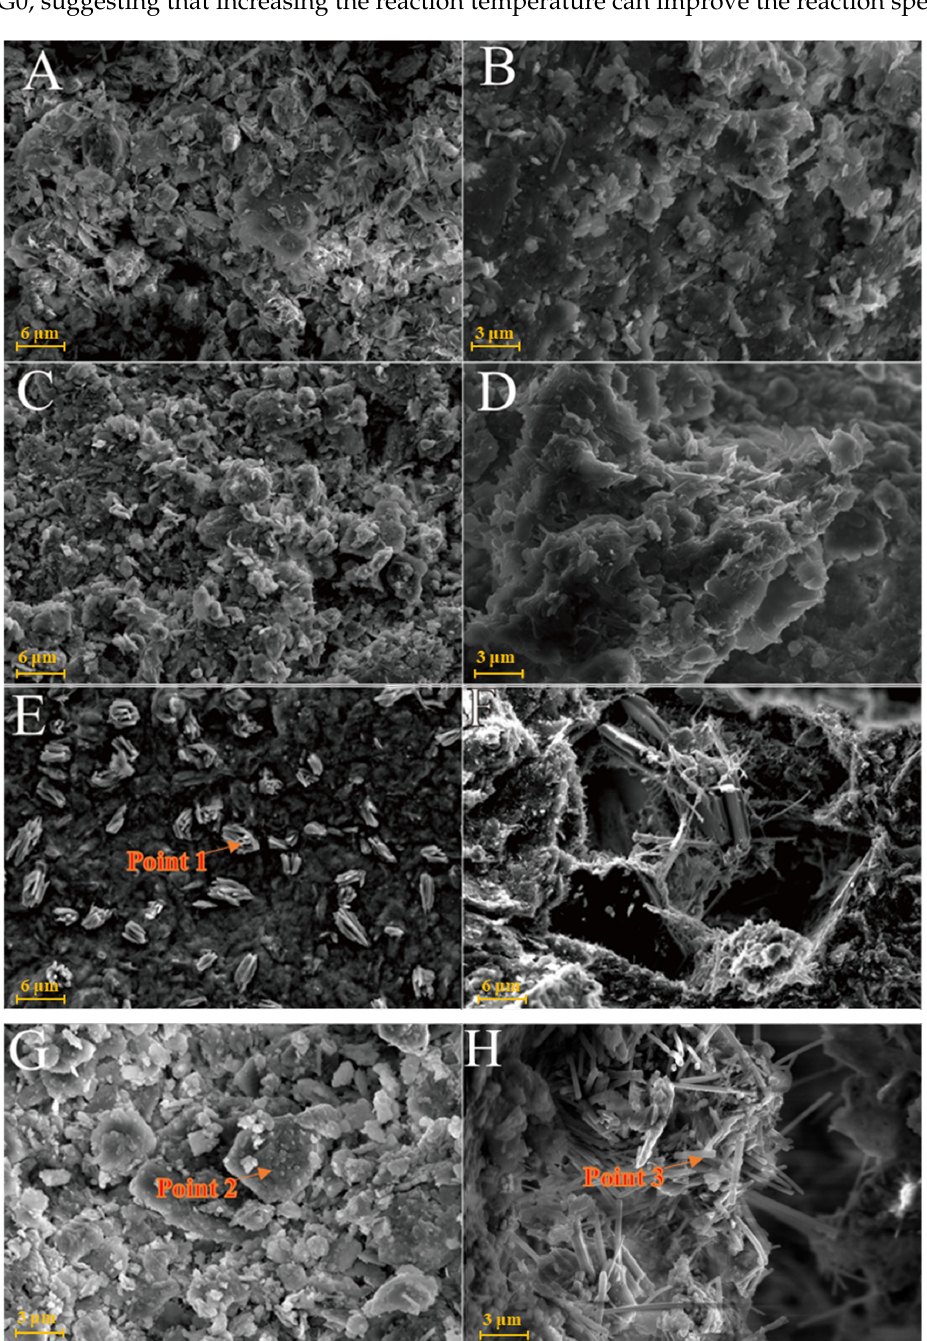
Figure 6. SEM images of kaolinite samples: ( A )—kaolinite raw material; ( B )—G0 samples cured for 3 days; ( C )—G0 samples cured for 7 days; ( D )—G0 samples cured for 28 days; ( E )—G0-2 samples cured for 3 days; ( F )—G0-2 samples cured for 7 days; ( G )—G0-2 samples cured for 28 days; ( H )— samples of G0-2 cured for 28 days.